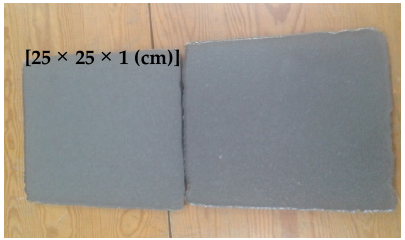
Figure 2. Paving Composite Material Fly ash.